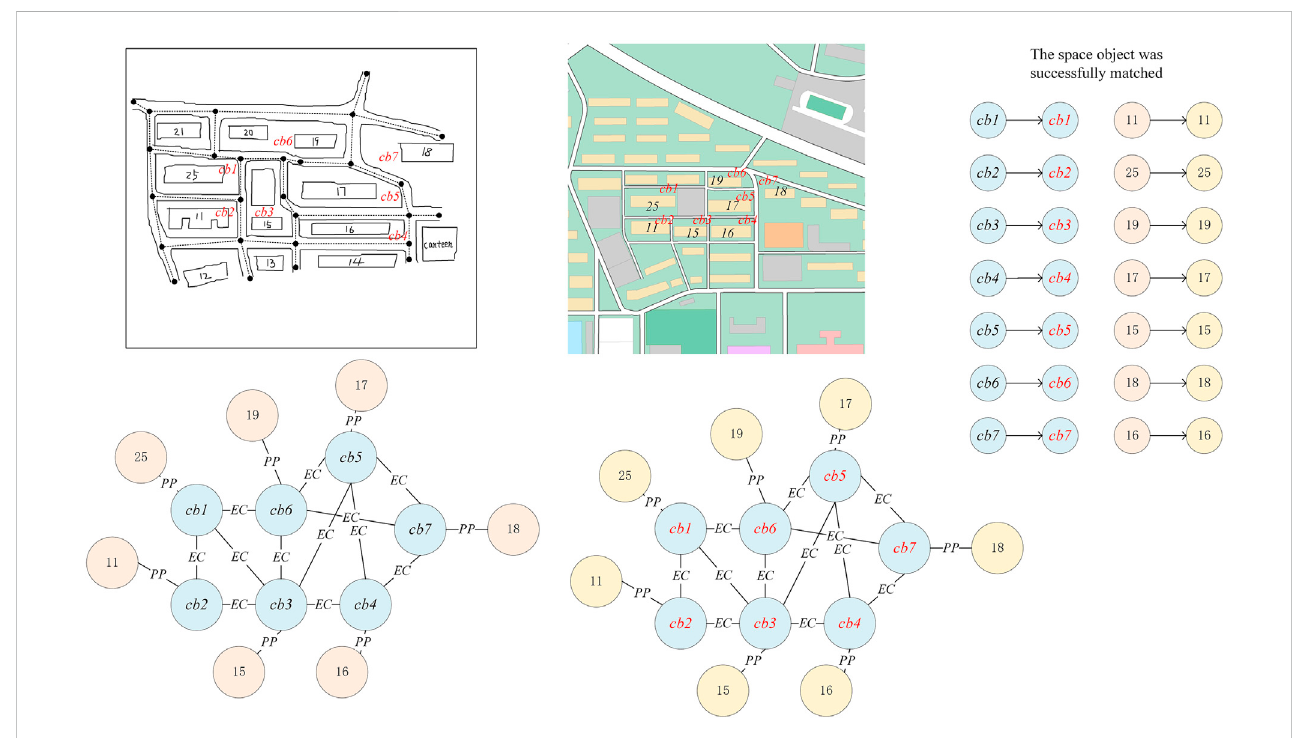
FIGURE 11 Landmark and city block priority matching